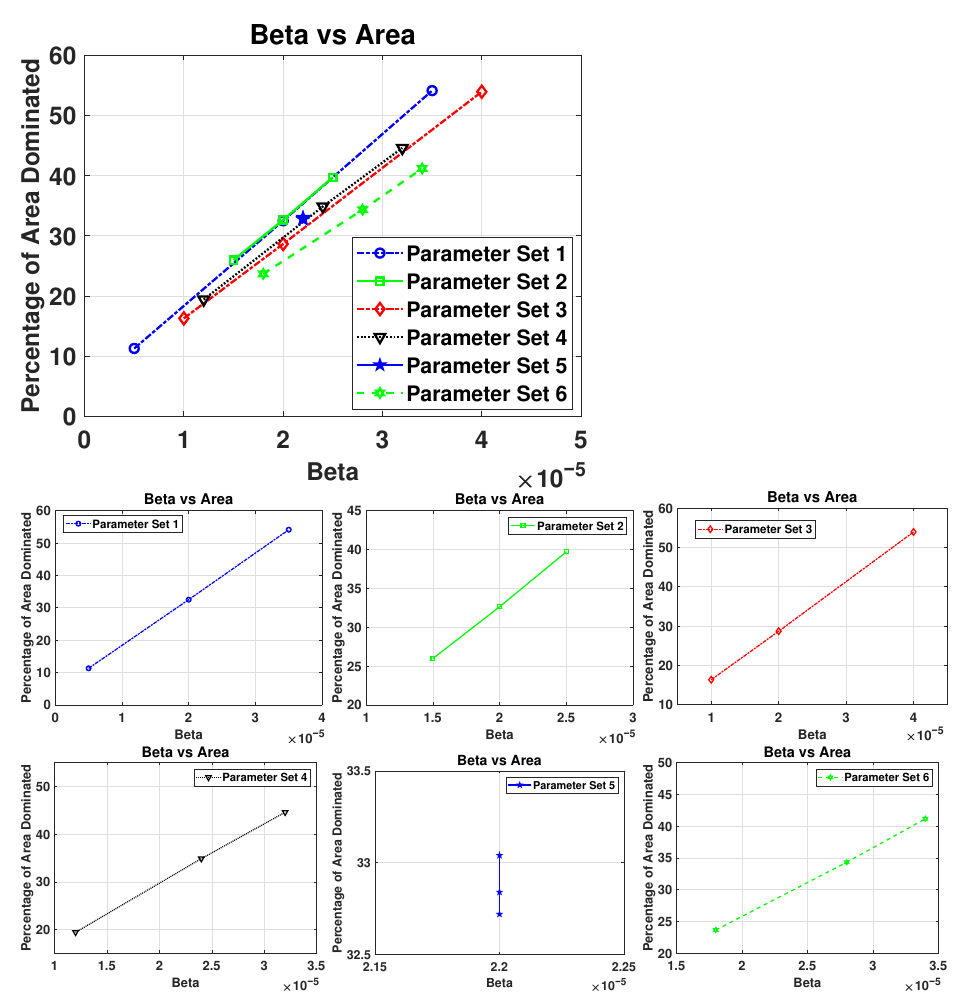
Figure 15. Here, we plot the β j values against the percentage of the area dominated by gang j for the Threat Level variation of the model. We use the six sets of parameters enumerated in Table